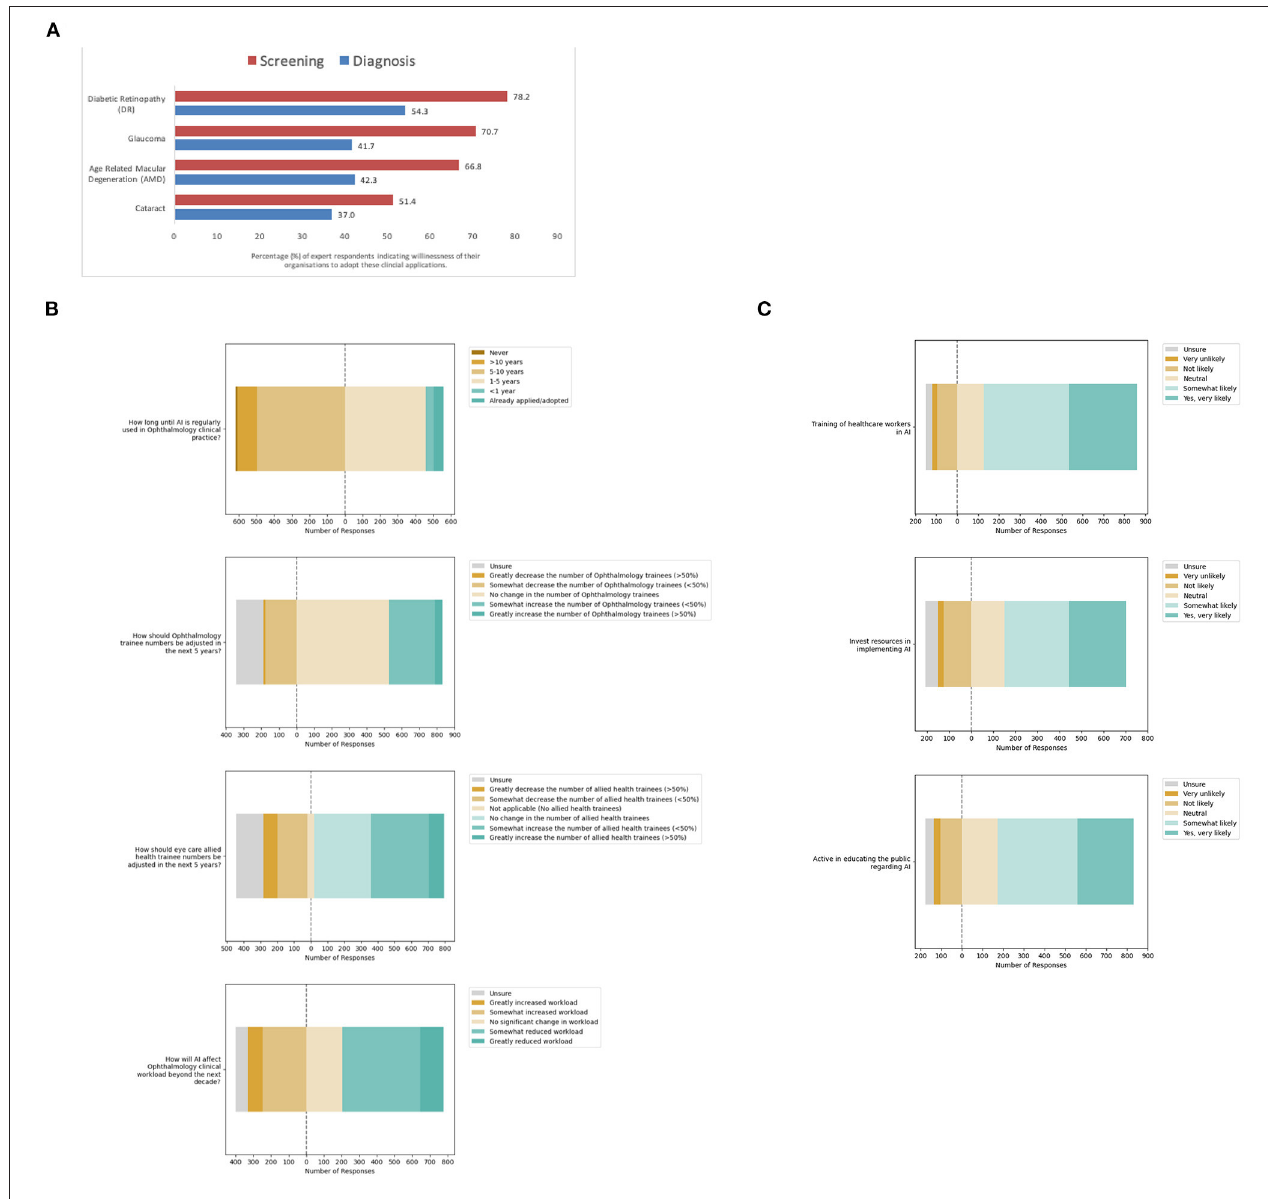
FIGURE 4 | Meso-system—Organizational adoption of clinical artificial intelligence (AI). (A) Organizational willingness to adopt AI for specific eye care services. (B) Anticipated organizational impact from adoption. (C) Perceived likelihood of organizational facilitation of adoption.